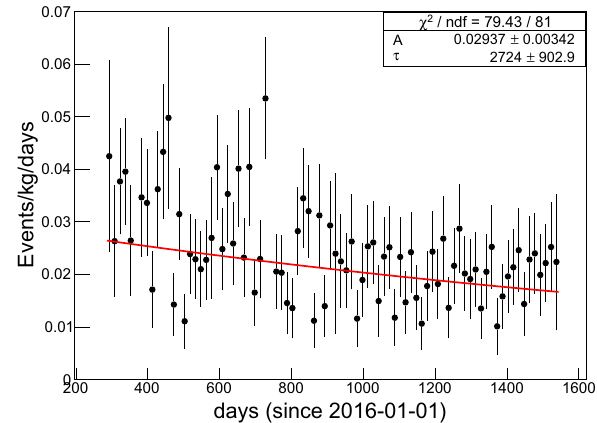
Fig. 8 Time dependent event rates of the selected two-pulse events fromthefivecrystalsaremodeledwithanexponentialdecaycomponent